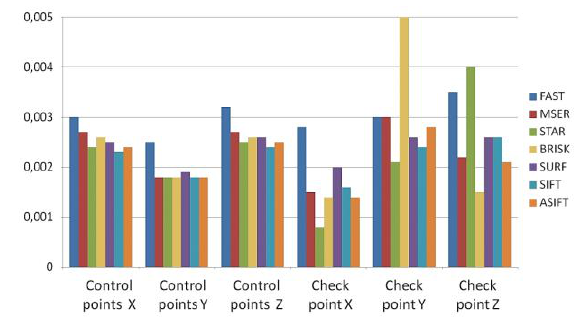
Figure. 6 Diagram of RMSE values for control and check points. Descriptors applied in the data orientation process are marked by different colours.